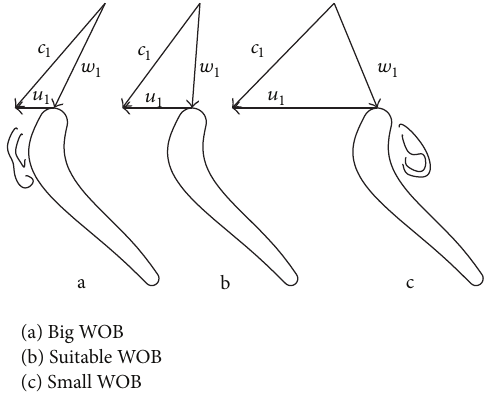
Figure 3: Hydraulic loss occurring on different